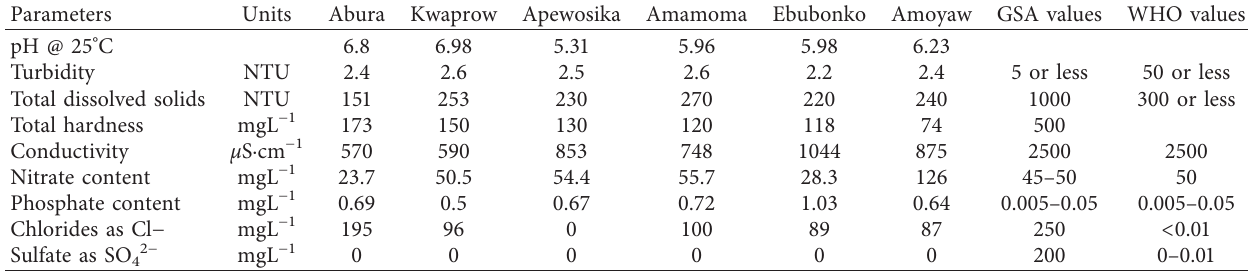
Table 1: Physicochemical parameters of water samples taken from some communities within the Cape Coast metropolis in the central region of